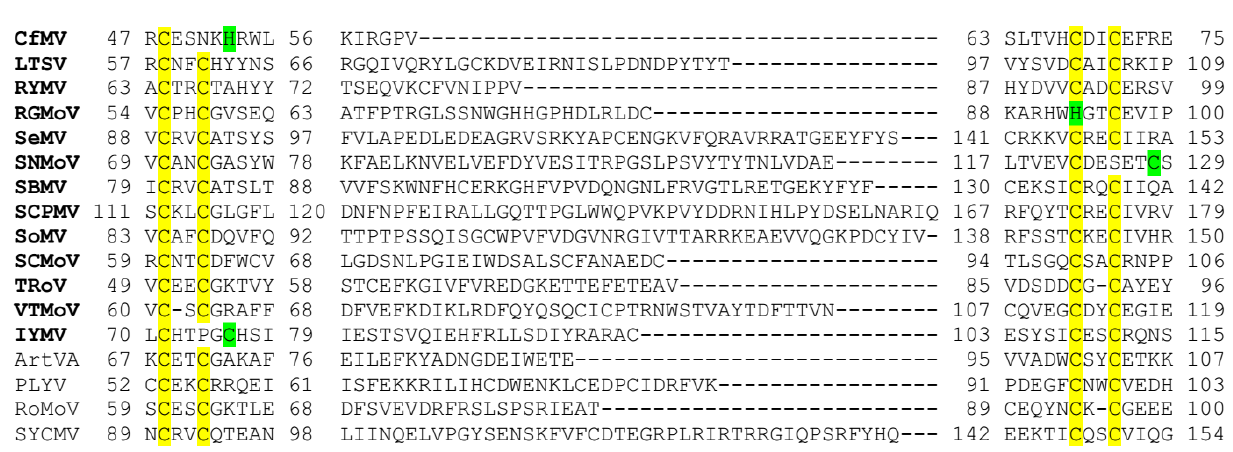
Figure 2. CLUSTAL O (1.2.1) multiple sequence alignment (manually adjusted). Sobemoviruses recognized by ICTV (bold); conserved cysteine residues of putative zinc-finger motif (yellow); histidine or cysteine residues close to the conserved position (green). The central part is not aligned because no homology is detected.